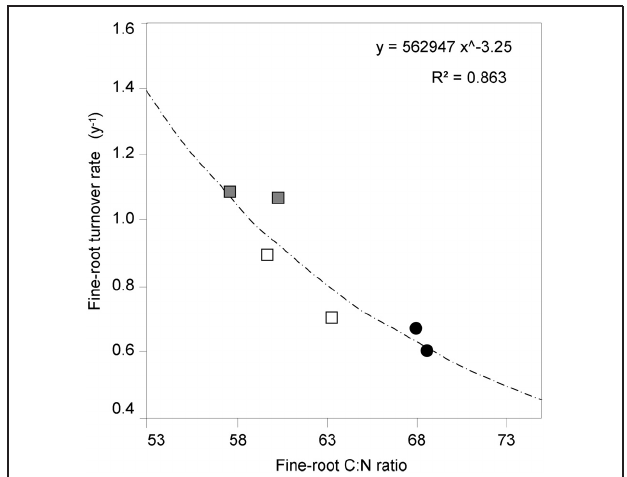
FIGURE 2 | The relationship between fine-root C:N ratio and fine-root turnover rate. C:N ratio data are estimated marginal mean values (means adjusted for diameter class covariates, N = 72). Significant turnover rate data ( p < 0 . 05) are from Table 3 in Montagnoli et al. (2012b) and refer to two different soil depths. Different symbols indicate different forest stands (